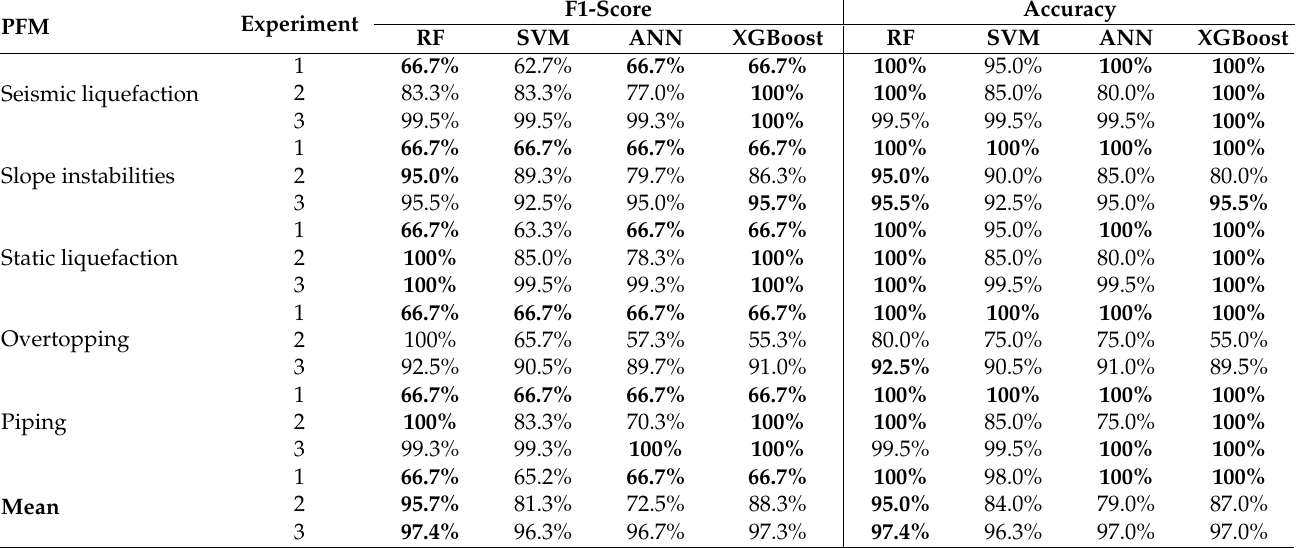
Table 4. Summary of results obtained in the RF, SVM, ANN, and XGBoost models PFM to be considered for the evaluation of PS of STD in the closure phase. Bold values show the best